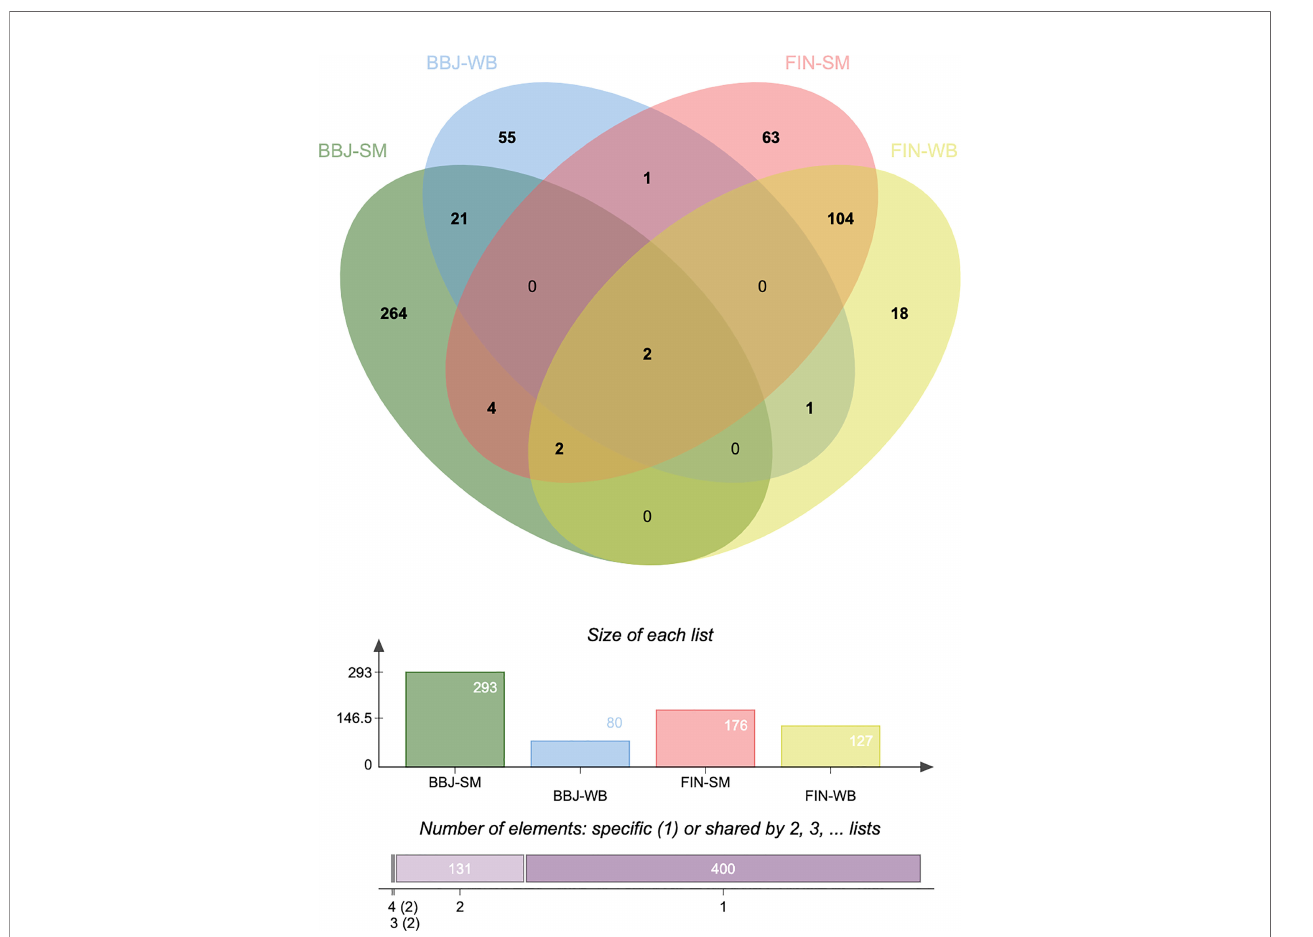
FIGURE 2 | Venn diagram reveals the overlap of transcriptome-wide association study (TWAS)-signi fi cant genes in different populations and tissues. TWAS: transcriptome-wide association study; BBJ, BioBank Japan; FIN, FinnGen; SM, skeletal muscle; WB, whole blood.